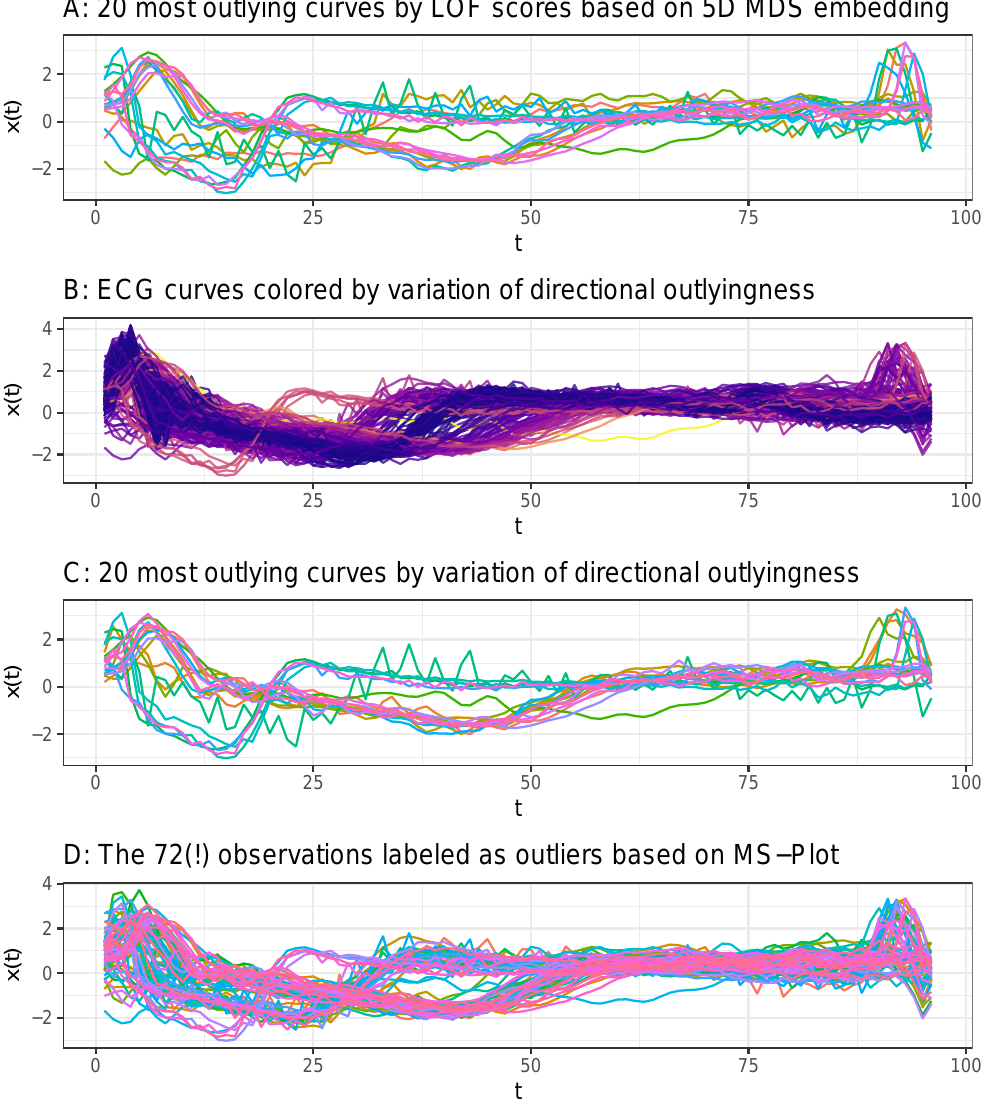
Figure 7. ECG data: LOF on MDS embeddings in contrast to directional